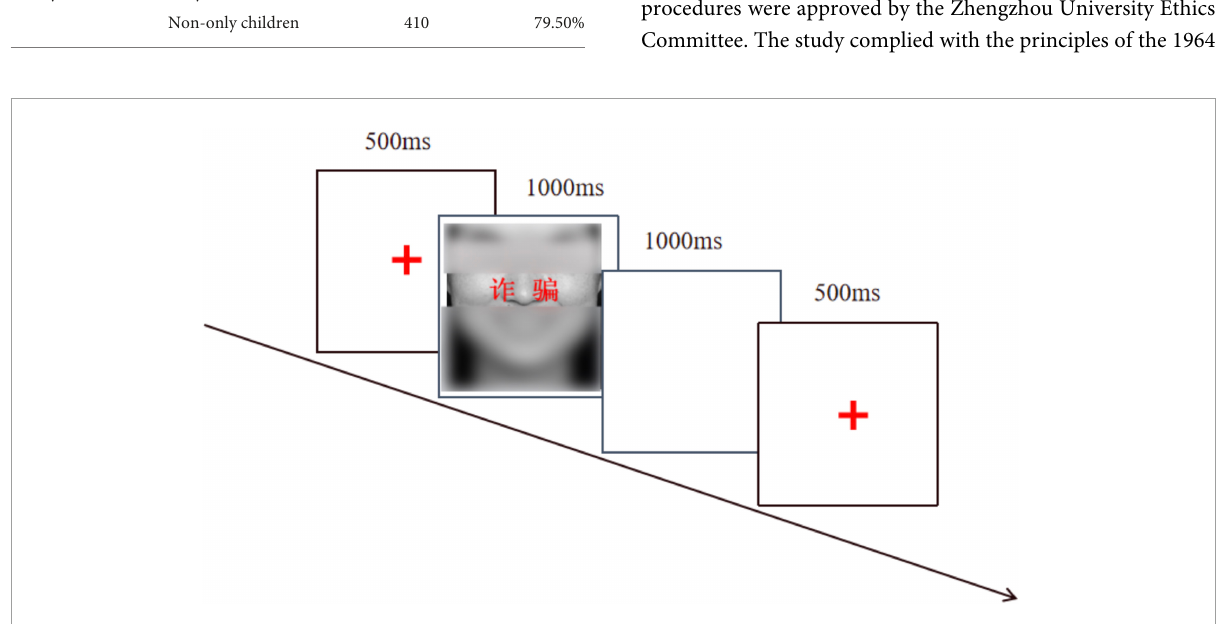
FIGURE2 The experimental trial of the Word-Face Stroop